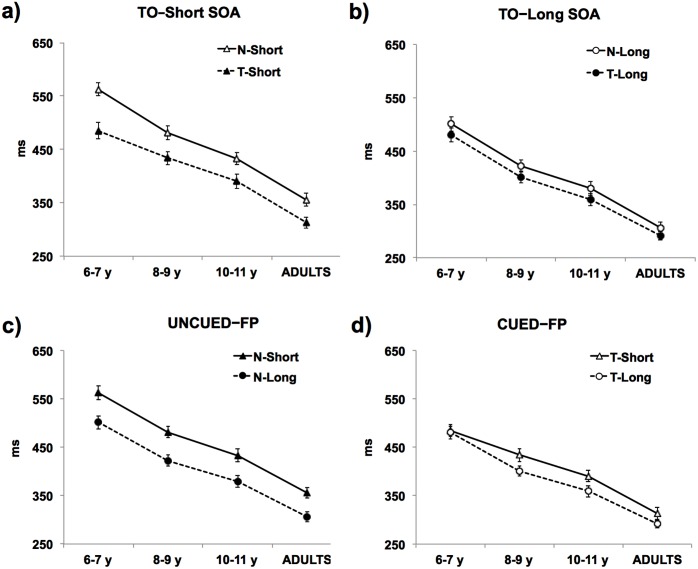
Mean reaction times.Panels show the pair-wise comparison of the mean reaction times for the TO–Short (a), TO–Long (b), Uncued–FP (c) and Cued–FP (d) effects for each age group. Error bars indicate standard errors of the mean.